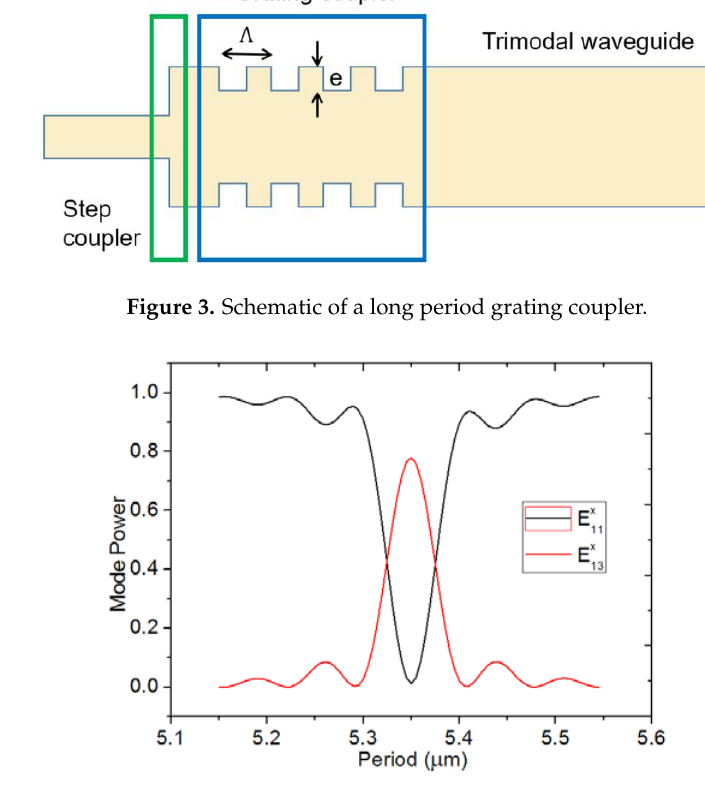
Figure 4. Change in the power of the fundamental mode and the first higher mode with the grating period with the period number being equal to 71.